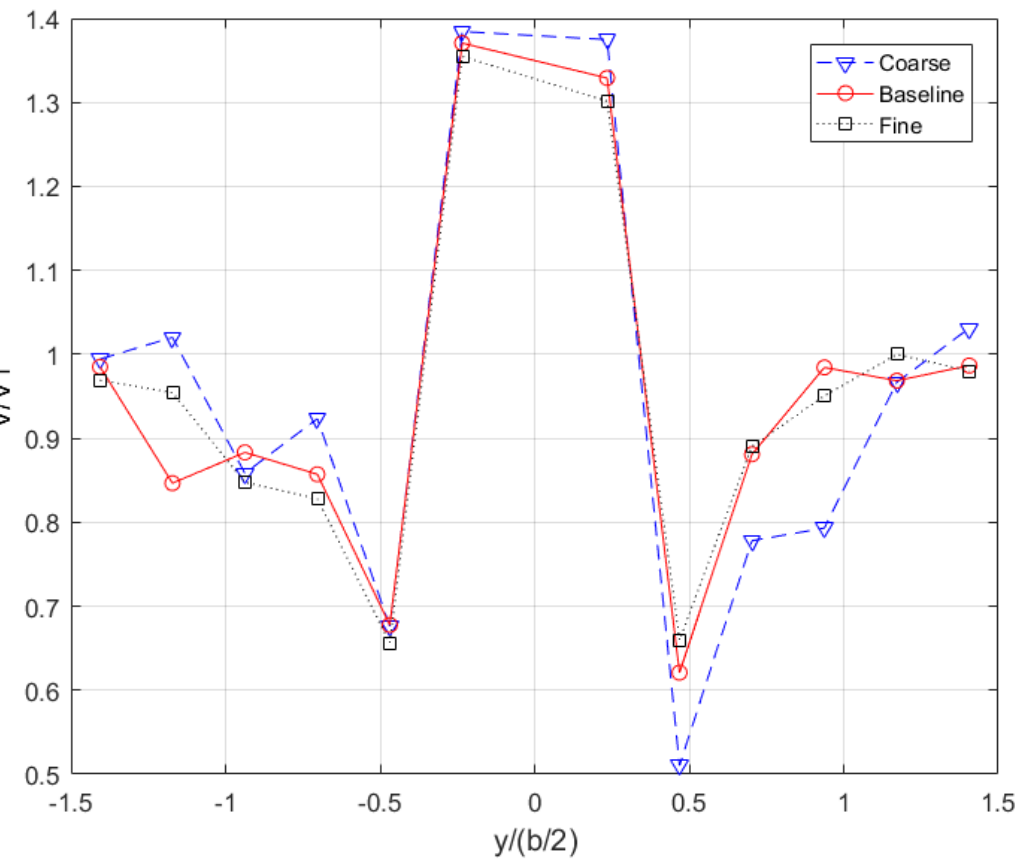
Figure 8. Comparison of experimental and calculated three velocity components at observation points.